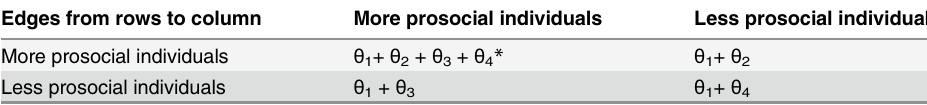
Table 6. Parameterization of the exponential random graph model (ERGM). Edges from rows to column More prosocial